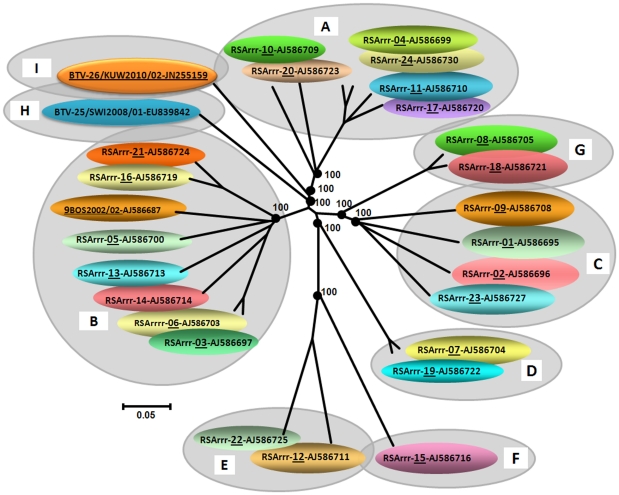
Neighbour-joining tree showing relationships between Seg-6 from KUW2010/02 with the twenty five reference strains of different BTV serotypes.The eight evolutionary branching points are indicated by black dots on the tree (along with their bootstrap values), dividing the sequences into nine ‘Seg-6 nucleotypes’ designated ‘A–I’. In previous studies, eight Seg-6 nucleotypes were identified. Members of the same nucleotype show >76% nt identity in Seg-6, while members of different nucleotypes show <76% nt identity [16]. However the analyses of BTV-26 (KUW2010/02) described here indicate that it forms a new 9th Seg-6 nucleotype (I), as it shows a maximum of 73.0%/79.3% nt/aa identity with previously existing BTV serotypes. Seg-6 accession numbers used for comparative analyses: AJ586695 - AJ586699, AJ586700, AJ586703 - AJ586711, AJ586713, AJ586714, AJ586716, AJ586719, AJ586720 - AJ586725, AJ586727, AJ586730, EU839842.